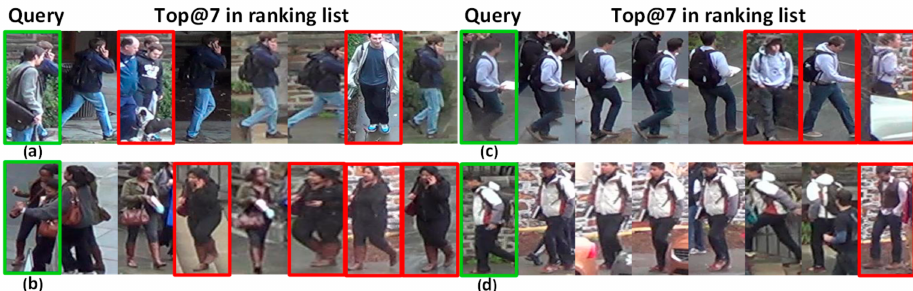
Figure 1. Top@7 in the ranking list of BagTricks [9] on DukeMTMC-ReID. The green boxes are the target pedestrian images, while the red boxes are the wrong